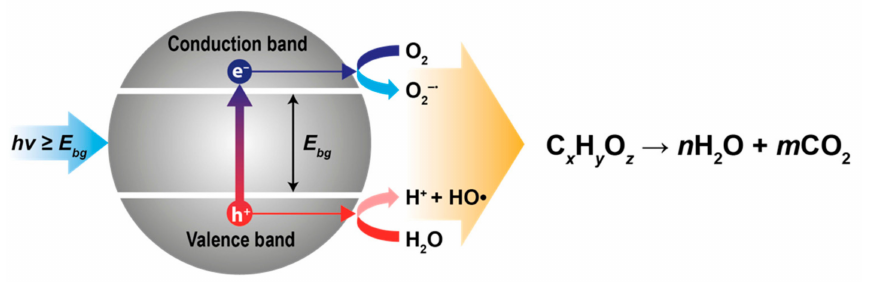
Figure 1. Schema of photocatalytic decomposition of organic pollutants, C x H y O z , where hv is the